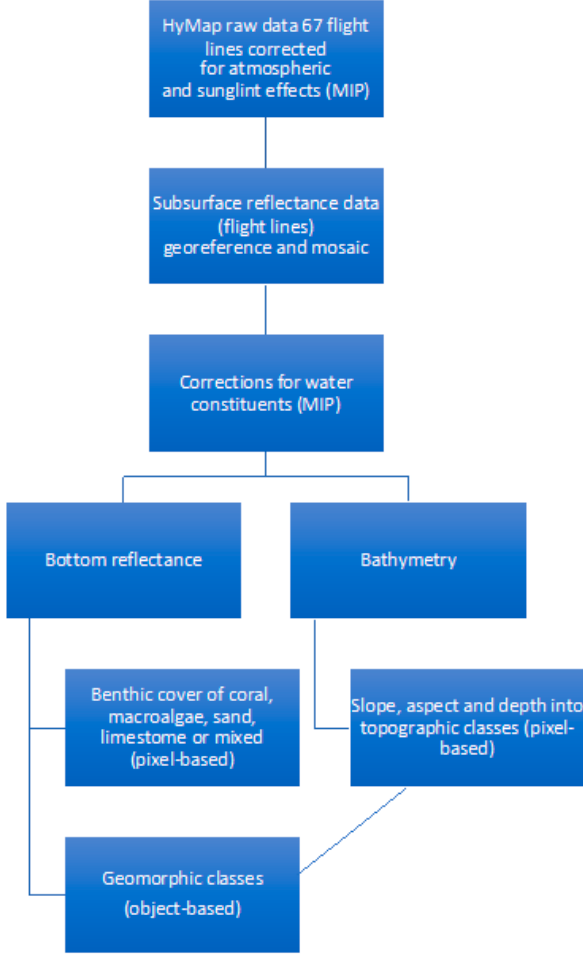
Figure 2. Summary of data processing steps used for the airborne hyperspectral survey at the Ningaloo Reef.